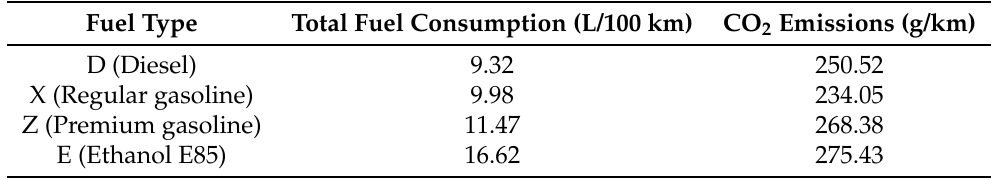
Table 8. CO 2 emissions (g/km) and total fuel consumption (L/100 km) of each fuel type. Fuel Type